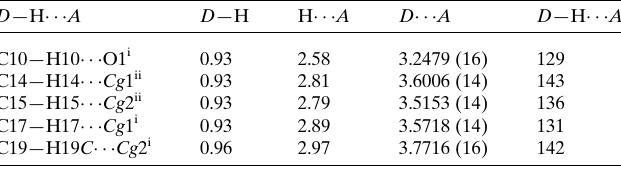
Table 1 Hydrogen-bond geometry (A˚ , (cid:3) ).